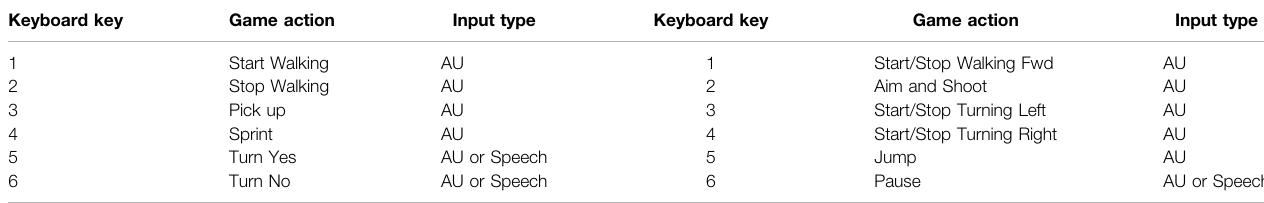
TABLE2| Left:Mappingsofthekeyboardkeystotheactionsde fi nedintheTempleLootergame.Right:Mappingsofkeyboardkeystotheactionsde fi